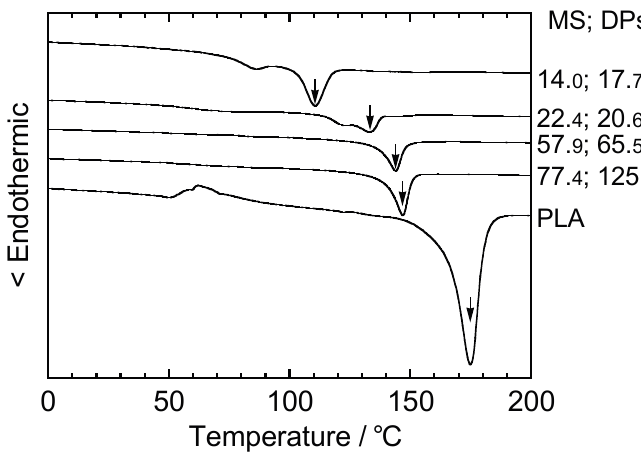
Figure 20. DSC thermograms of CA 2.15 - g -PLA samples at different MS values. Arrows indicate T m positions taken as endothermic peak maxima. Reproduced with permission from ref. [55]. Copyright 2003 Elsevier Science